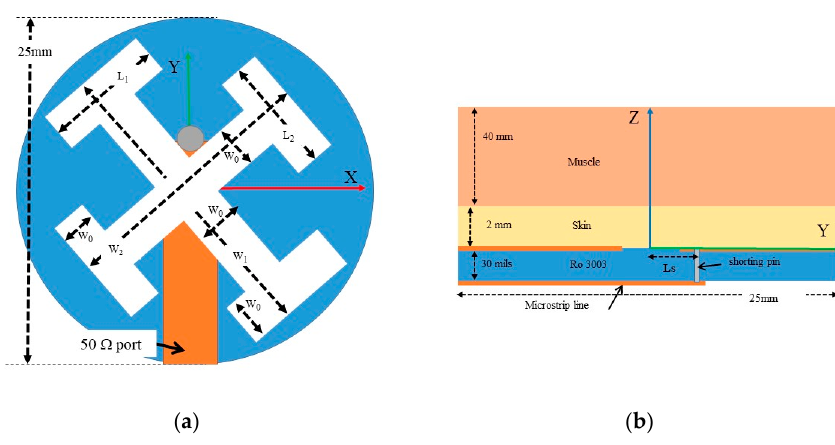
Figure 2. Scheme of the asymmetric Jerusalem-cross slot antenna. ( a ) Top view, ( b ) side view.